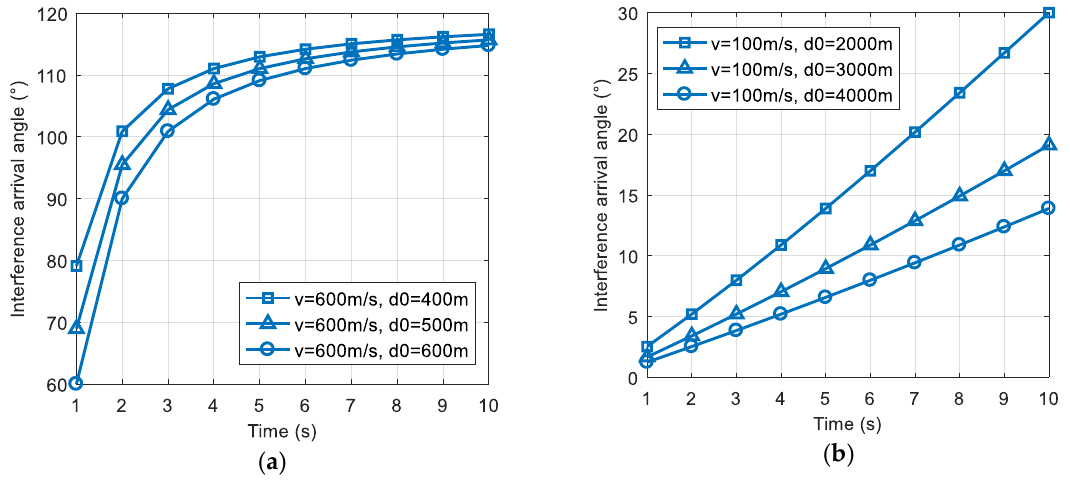
( b ) Figure 2. The change of the interference direction with the relative motion velocity v . ( a ) The change of the interference direction in the case where  vt d 0 ; ( b ) the change of the interference direction in the case where